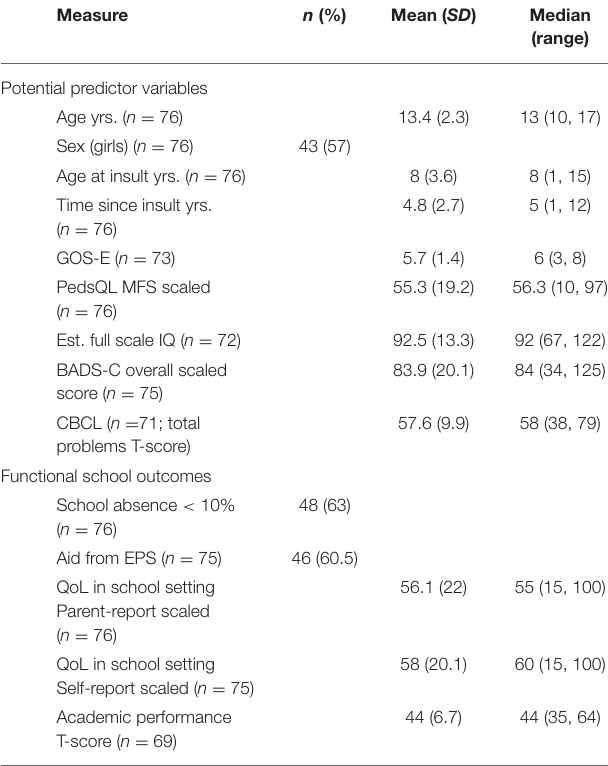
TABLE 2 | Scores on potential predictor variables and functional school